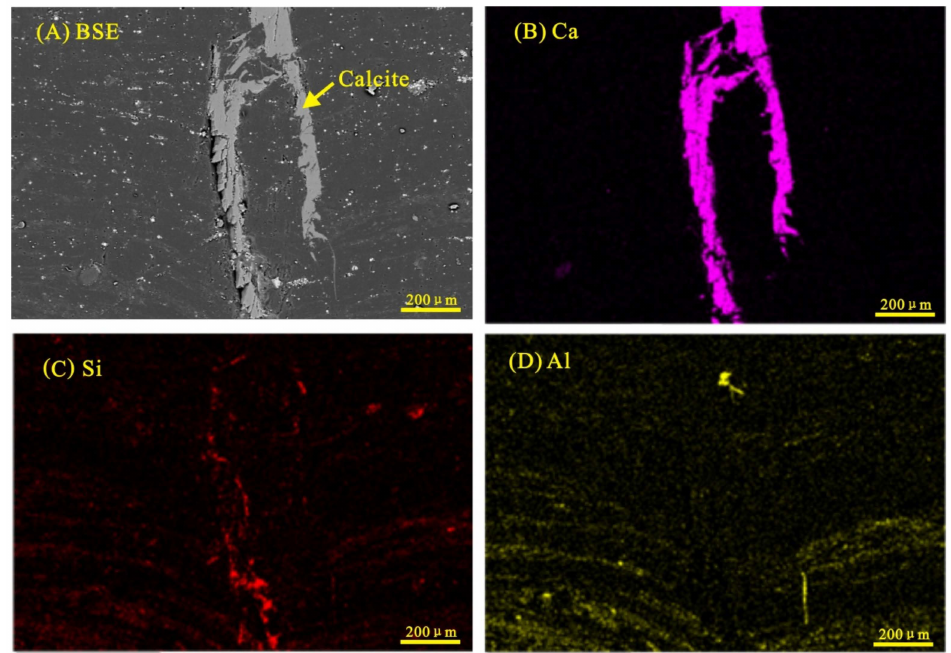
Figure 10. SEM-EDS mapping showing the distribution of Ca, Si, and Al (sample CLB4-7). ( A ): SEM back-scattered electron images of minerals; ( B )–( D ): the distribution of Ca, Si, and Al, respectively.